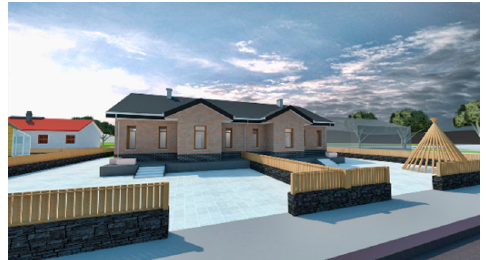
Figure 8. North façade of the demonstration building.